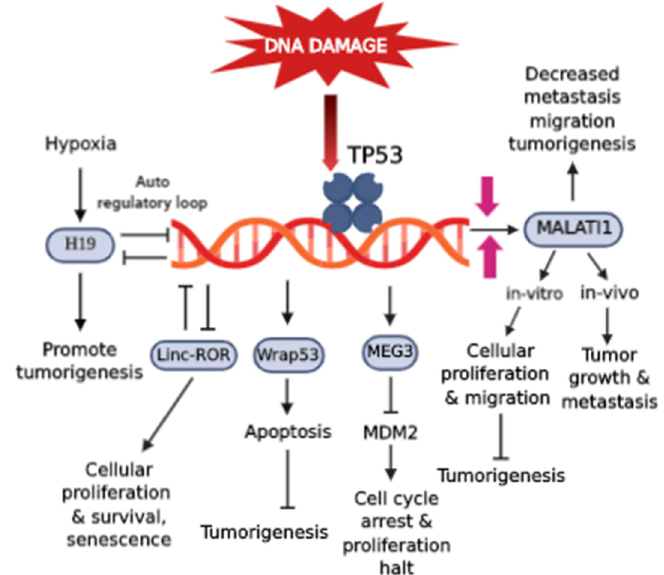
Figure 2. The role of p53-regulators of lncRNAs that directly and / or indirectly regulate p53 activity either repressing and / or activating its expression levels. MEG3 downregulates MDM2 expression that activates p53 resulting in cell cycle arrest and inhibits cell proliferation and tumorigenesis. Other lncRNAs like H19, RoR, act in an autoregulatory loop in cooperation with TP53. In OC tumor tissues, H19 has been observed to induce cell cycle arrest and apoptosis [116].